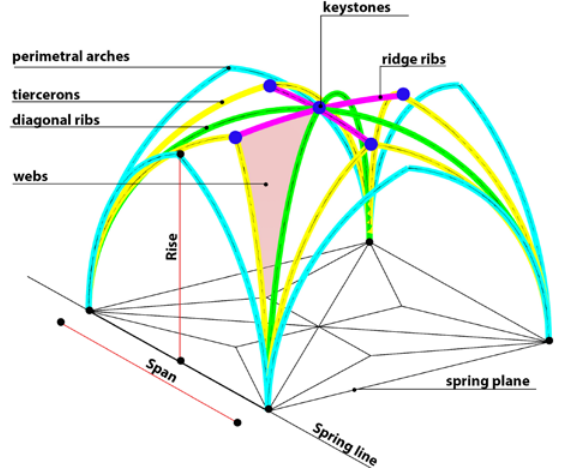
Figure 3. Main terms and main elements for